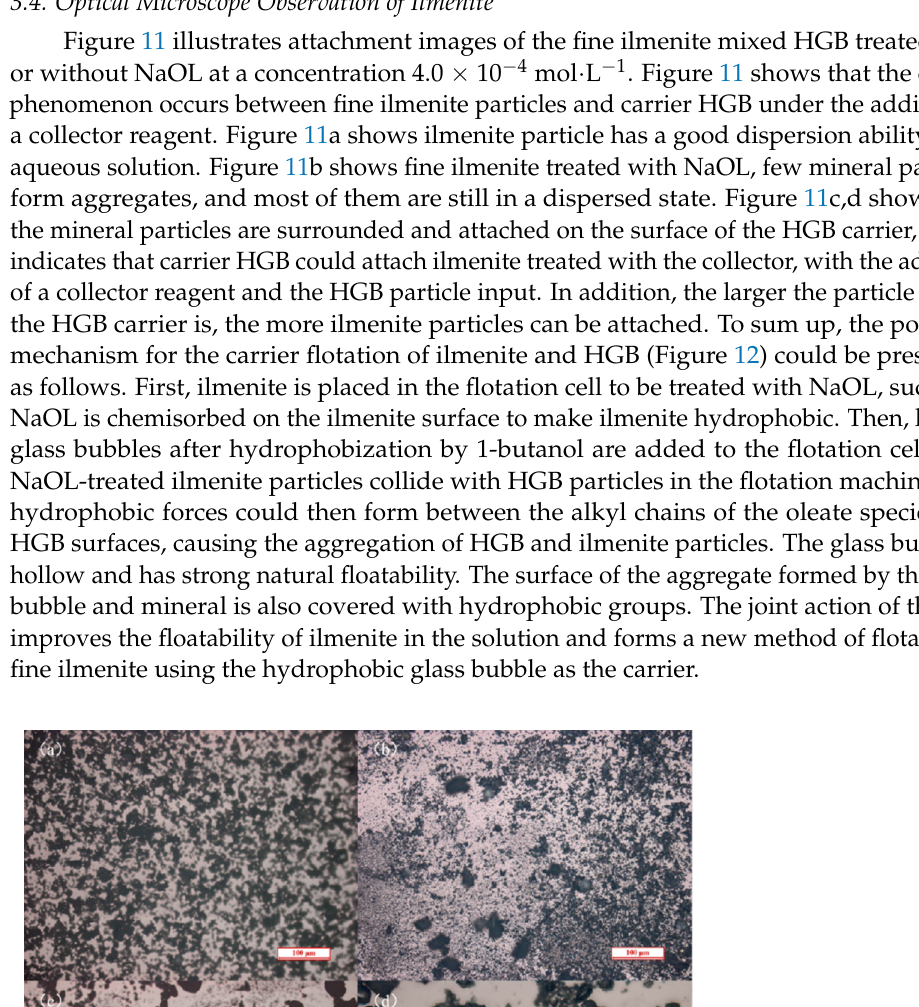
Figure 12. Carrier flotation model of HGB particles promotes ilmenite flotation behavior. 4. Conclusions HGB was studied as the carrier to promote fine-grained ilmenite recovery. The micro- flotation results showed that the floatability of fine ilmenite and titanaugite remarkably decreased compared with that of coarse ilmenite and titanaugite. HGB could improve the flotation of ilmenite and titanaugite using NaOL as collector and sodium silicate as de- pressant to separate ilmenite from titanaugite and achieve the best separation effect at pH 6.0. The flotation recovery difference between ilmenite and titanaugite increased from ap- proximately 32.87% to 52.11%. The results of FTIR analysis revealed that NaOL chemi- sorbed onto the surface of the mineral particles and physisorbed on the HGB surfaces. Optical microscope observation results indicated that ilmenite particles treated with NaOL solution can be attached on the surface of the HGB, and larger HGB particles can attach more ilmenite particles. According to the XDLVO theory, the total energy of inter- action calculation results showed that total energy depended not only on electrostatic and London–van der Waals interactions, but also on acid–base interactions. The surface free energy and zeta potential of mineral and carrier were the main factors affecting the acid–